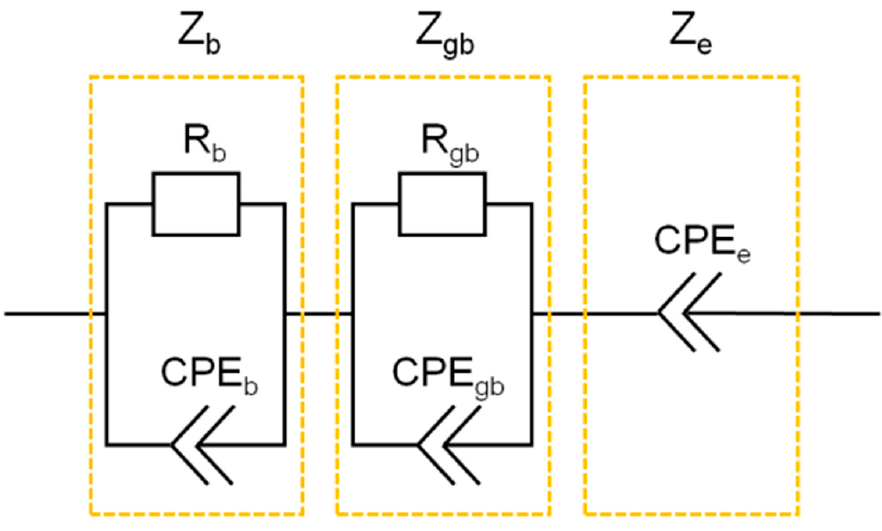
Figure 3. The equivalent circuit used to interpret the results of electrical measurements. The circuit includes three impedances connected in series related to the impedance of the bulk material, Z b , the grain boundary impedance Z gb , and the electrode impedance Z e . Each element of the circuit corresponds to a different stage of ion transport or po- larization in the material. Bulk impedance and grain boundary impedances include two elements: resistance (R b and R gb ) and constant phase element ( CPE b and CPE gb ). The electrode impedance is described by the constant angle element CPE e , a special case of which is the Warburg impedance. The volume resistance of the sample is related to the value of the volume conductivity, σ b , by the ratio σ b = 1/R b (d/S), where d is the pellet thickness and S is the electrode area. The value of the bulk conductivity is described by the Arrhenius